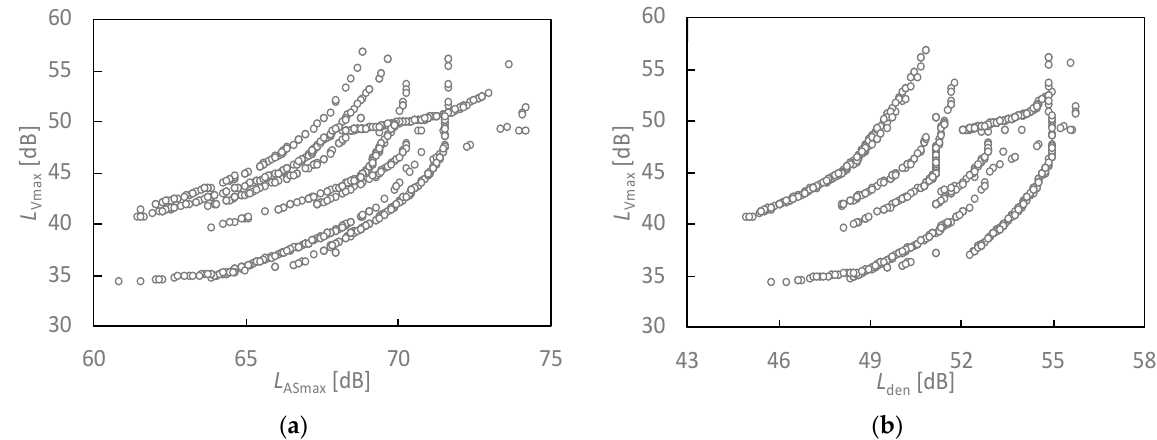
Figure 2. Relationships between noise exposure level and vibration level. ( a ) Relationship between L ASmax and L Vmax ; ( b ) Relationship between L den and L Vmax .